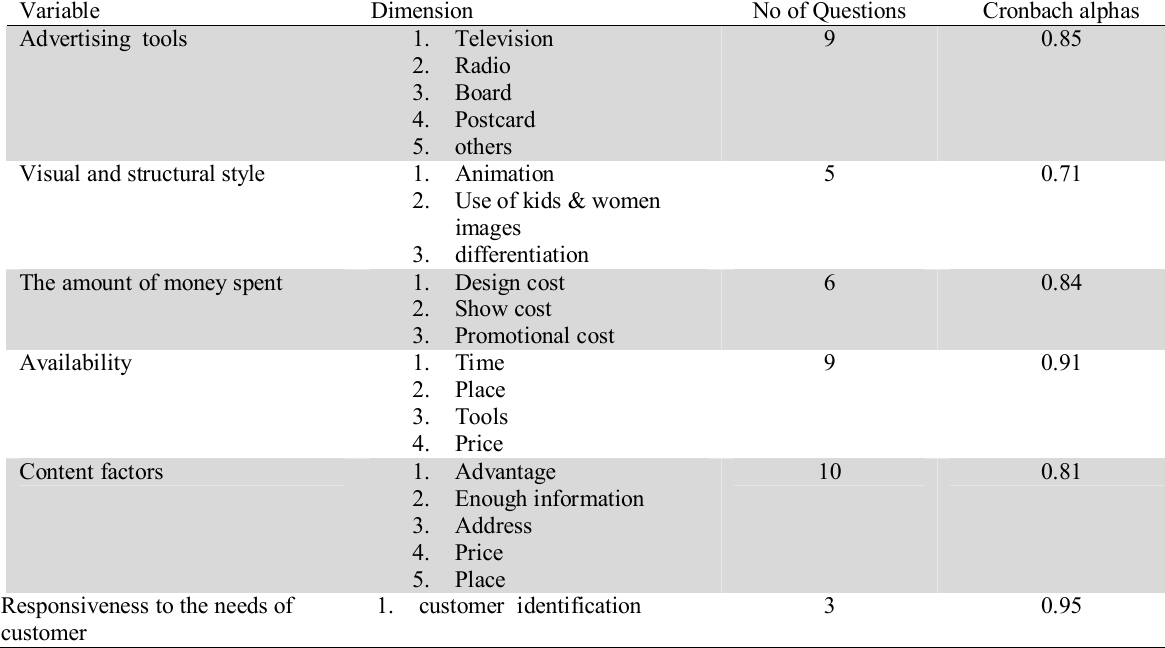
Questions into the